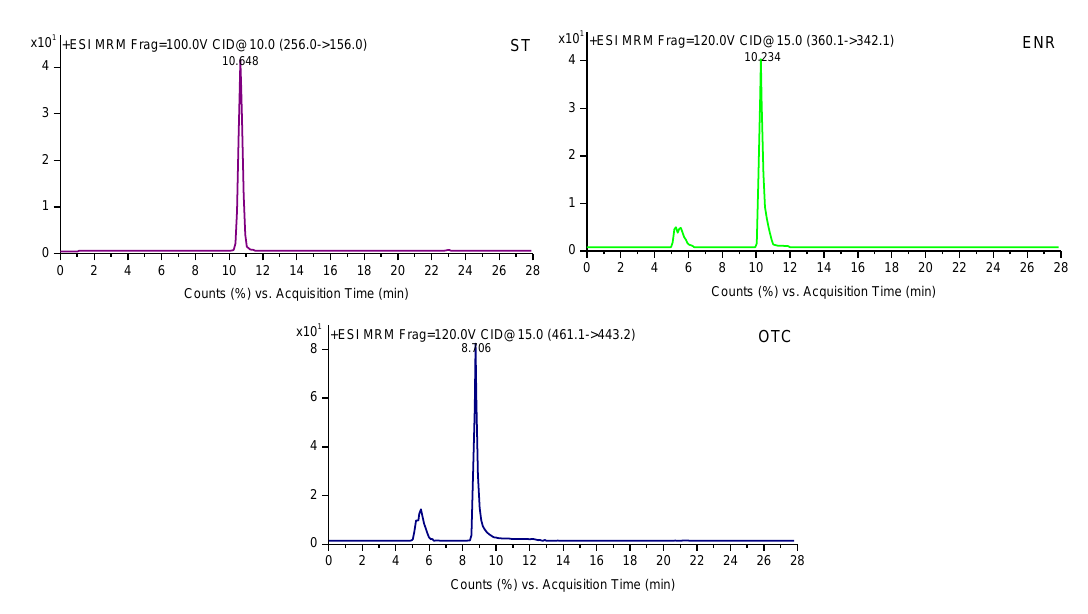
Figure 4. MS/MS spectrogram of eleven antibiotics. Table 5. Precursor masses and product ions for mass spectrometry MRM analysis of the selected antibiotics.